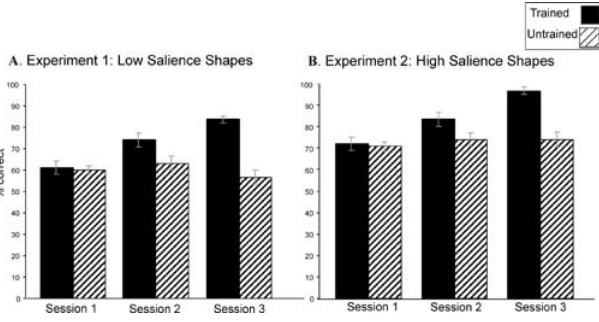
Figure 8. Behavioral Data during Training